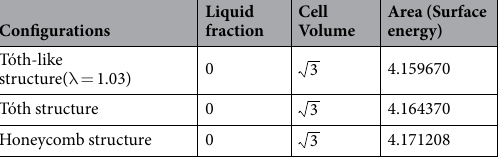
Table 1. The results of bilayer monodisperse systems for the dry foams, for H = 2.00.